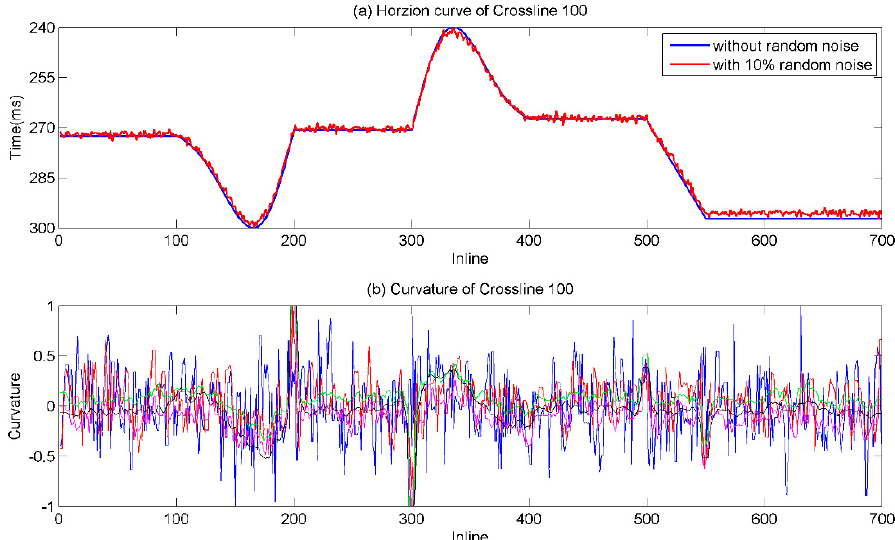
Figure 7. Horizon curve and mean curvature attribute with 10% noise: ( a ) Horizon curve and ( b ) mean curvature attribute of different time windows with 10% noise. Table 3. Correlation coe ffi cient for di ff erent time windows with 5% Table 4. Correlation coefficient for different time windows with 10% noise.